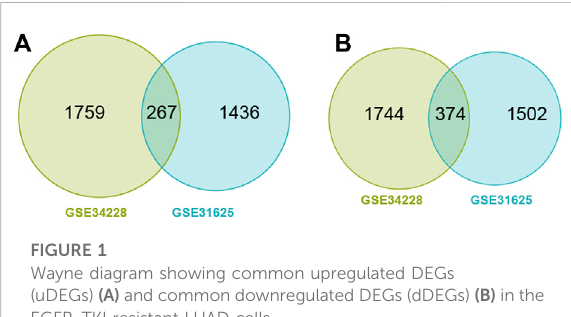
FIGURE 1 Wayne diagram showing common upregulated